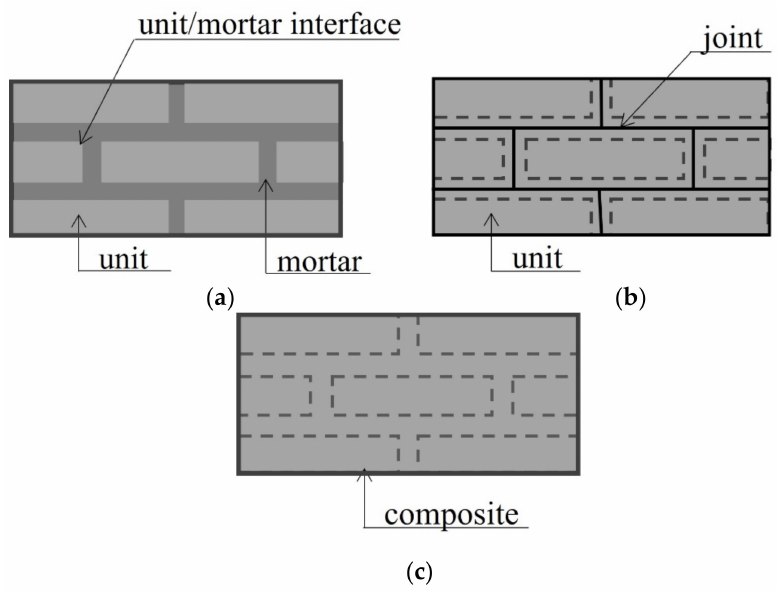
Figure 10. Modelling strategies for masonry structures (adapted from [27]): ( a ) detailed micro- modelling, ( b ) simplified micro-modelling, ( c )